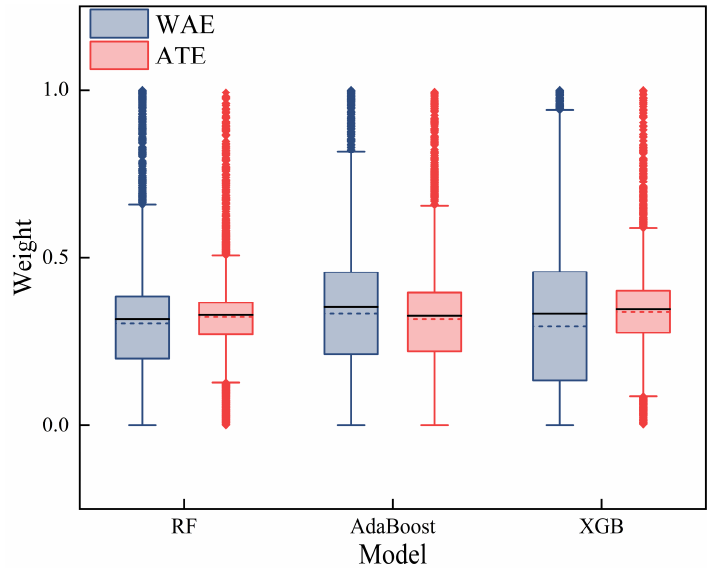
Figure 10. Visualization results for base model weights. The solid lines inside the boxes are the average values.